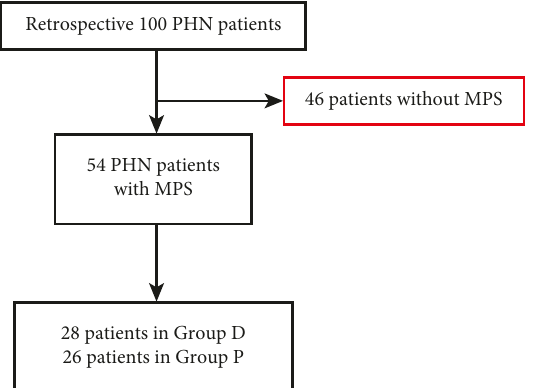
Figure 1: Flowchart of study inclusion and